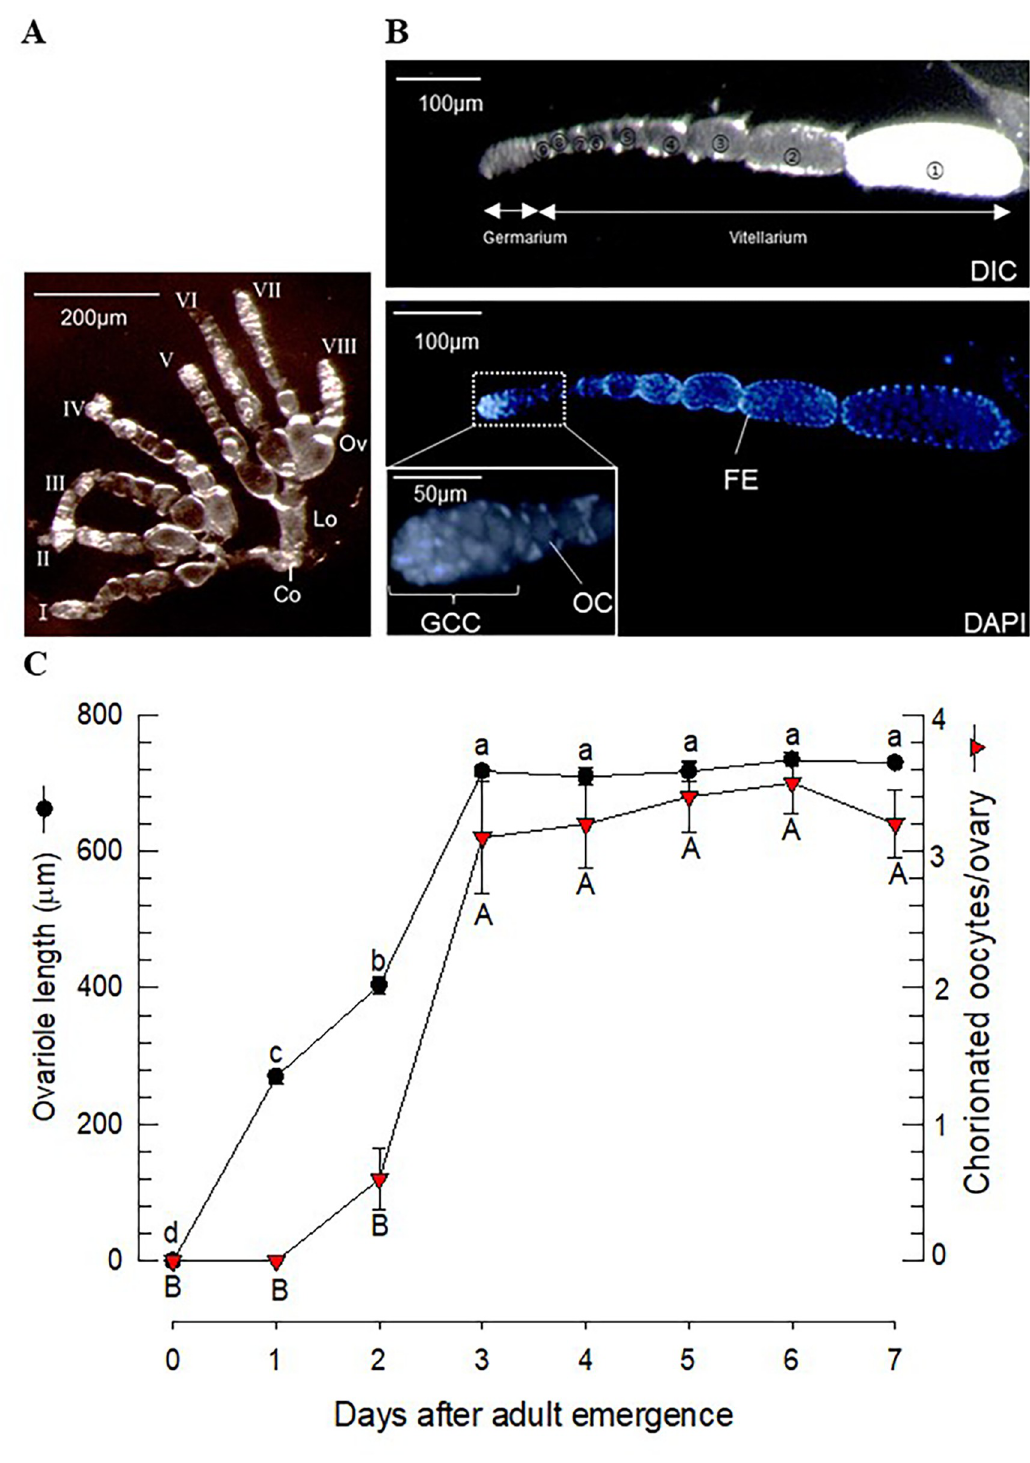
Fig 1. Ovarian development of F . occidentalis . (A) Internal reproductive organs of 2-day-old females include a pair of ovaries (‘Ov’), 8 ovarioles (‘I-VIII’), a lateral oviduct (‘Lo’), and a common oviduct (‘Co’). (B) Ovariole structure divided into the germarium and the vitellarium. A total of 9 follicles are numbered from proximally to distally in the differential interference contrast (‘DIC’) picture. The white follicle represents chorionated oocytes. In the DAPI picture, each oocyte in the follicle is surrounded by follicular epithelium (‘FE’). In the germarium, the germ cell cluster (‘GCC’) is located near to the oocyte (‘OC’). (C)